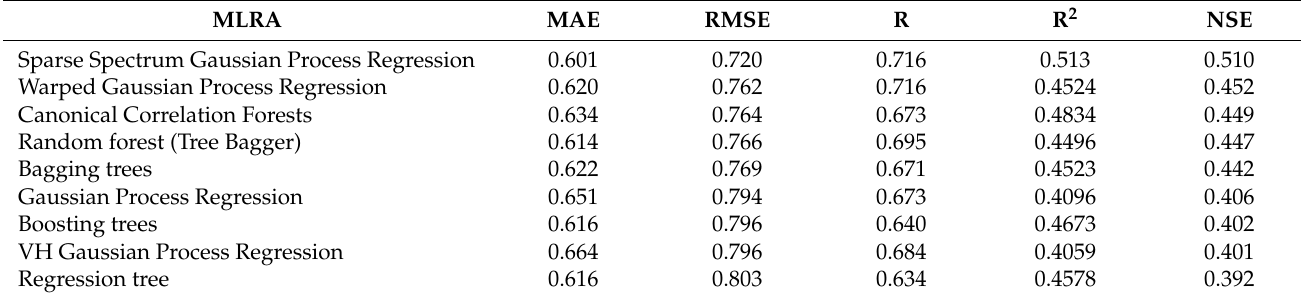
Table 7. Estimation accuracy of the best-performing prediction models of EC Soil derived from Sentinel-2 spectra. MAE: Mean Absolute Error; RMSE: root-mean-square error; R: coefficient of correlation; R 2 : coefficient of determination; NSE: Nash–Sutcliffe